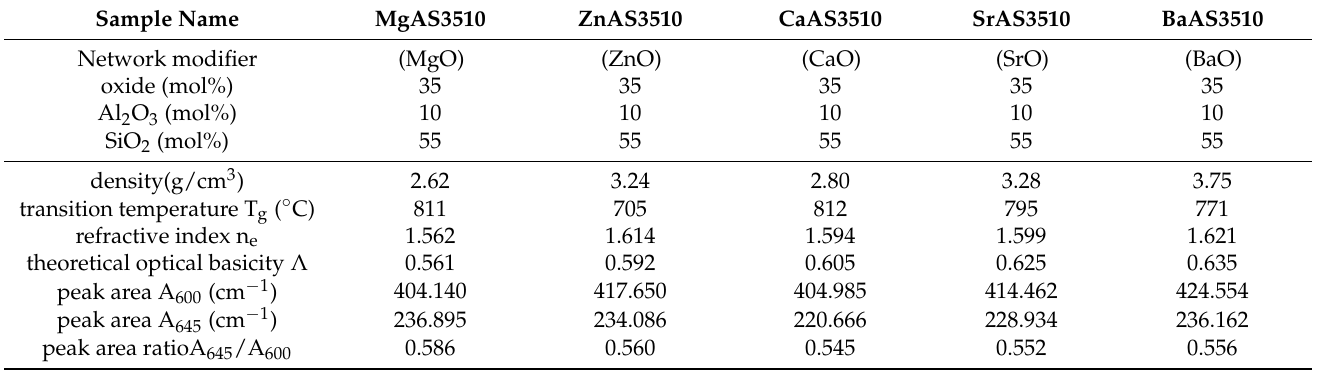
Table 1. Chemical compositions, densities, transition temperatures T g , refractive indices n e , theoret- ical optical basicities Λ , peak areas A 645 , A 600 and peak area ratios A 645 /A 600 of the transitions at 645 nm (“hypersensitive”) and the transitions at 600 nm of the studied